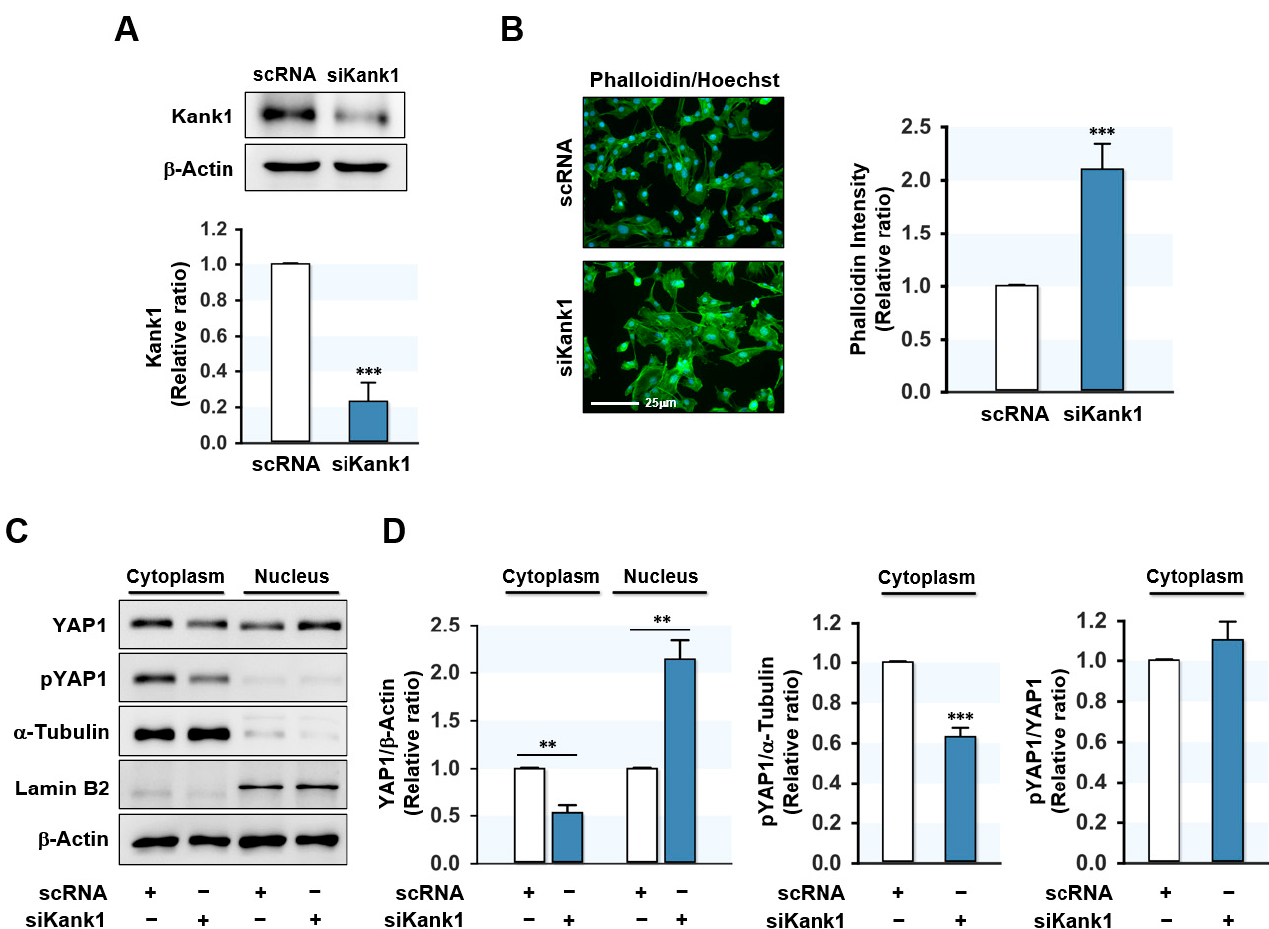
Figure 2. Depletion of Kank1 increased F-actin and nuclear YAP1. C2C12 cells were transfected with control (scRNA) or Kank1 siRNA (siKank1) at a concentration of 200 nM for 24 h. ( A ) Kank1 expressions were analyzed by immunoblotting and then intensities of densitometry were normalized versus ß-actin. Values are expressed as relative ratios versus scRNA control. ( B ) After transfection, cells were stained with FITC-phalloidin (green) and Hoechst 33,342 (blue) for the F-actin and nucleus, respectively. Scale bar: 25 μ m. Phalloidin intensities were determined with ImageJ software. ( C , D ) The expressions of cytoplasmic and nuclear YAP1 and phosphorylated YAP1 (pYAP1) were analyzed by immunoblotting. The quality of subcellular fractions was verified with cytoplasmic ( α -tubulin) or nuclear (lamin B2) markers. Values are shown as relative ratios versus scRNA control. All results are presented as means ± SEMs ( n > 3), and levels of significance are presented as **, p < 0.01; ***, p < 0.001 vs. scRNA controls.